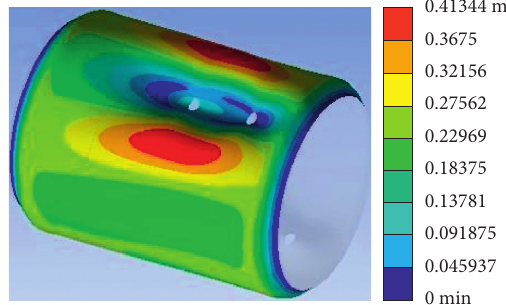
Figure 7: Cloud diagram of total deformation of the drum.